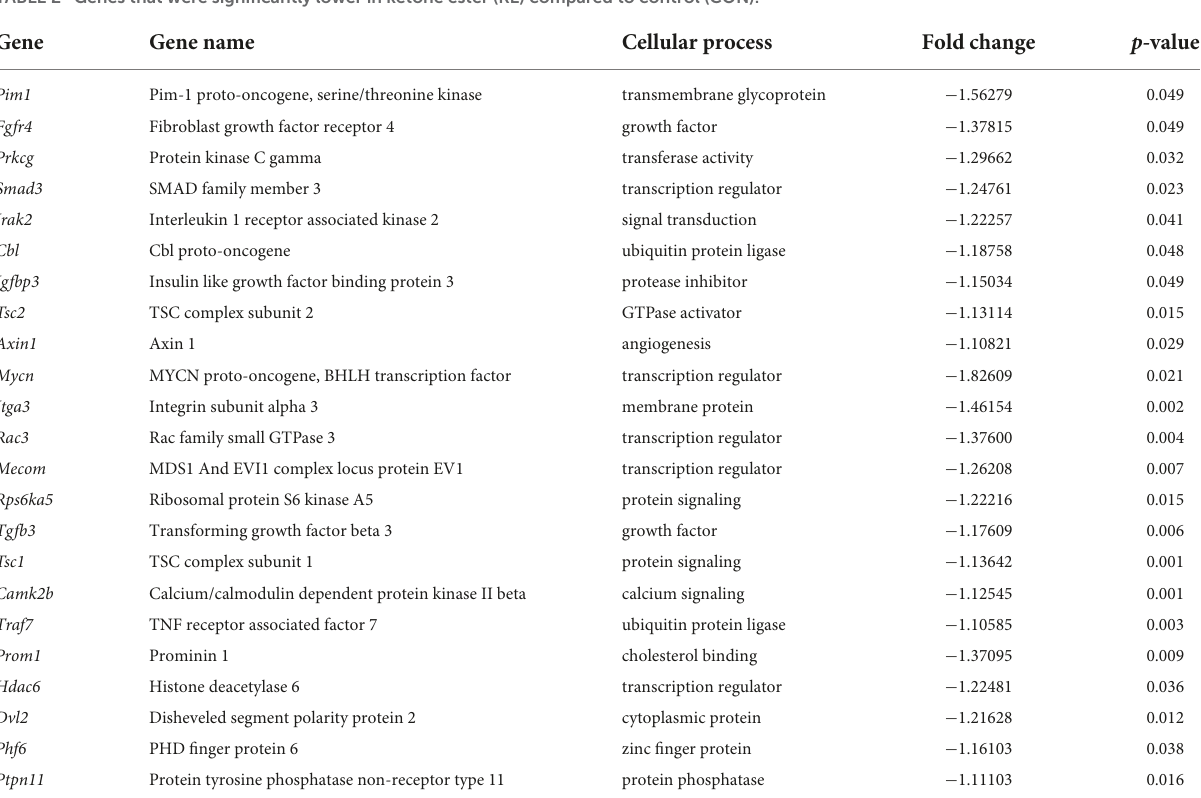
TABLE 2 Genes that were significantly lower in ketone ester (KE) compared to control